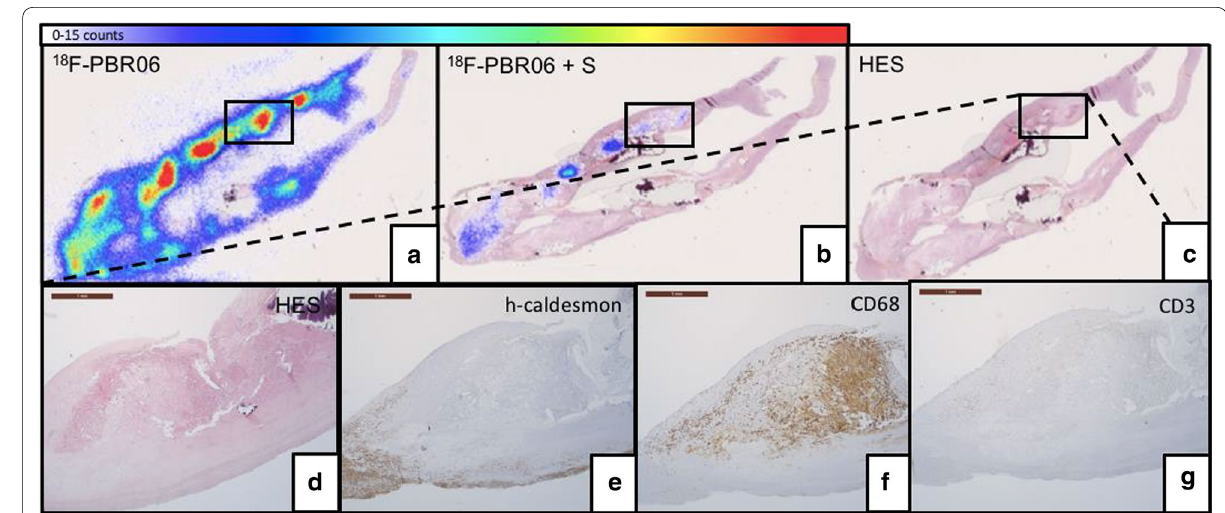
Fig. 2 [ 18 F]‑PBR06 autoradiography at baseline ( a ) and after pre‑incubation with cold [ nat F]‑PBR06 ( b ) and HES anatomical sections ( c ) in a piece of carotid endarterectomy. A large atheromatous plaque with calcification invaded the intima and tunica media of the arterial wall ( d , 25). × Immunohistochemistry showed destruction of the tunica media by the plaque ( e , 25), macrophage infiltration around the cholesterol clefts ( f , × 25), and scattered T‑lymphocytes ( g , 100) within the plaque. The brown bar in the upper left corner is a 1‑mm scale × ×